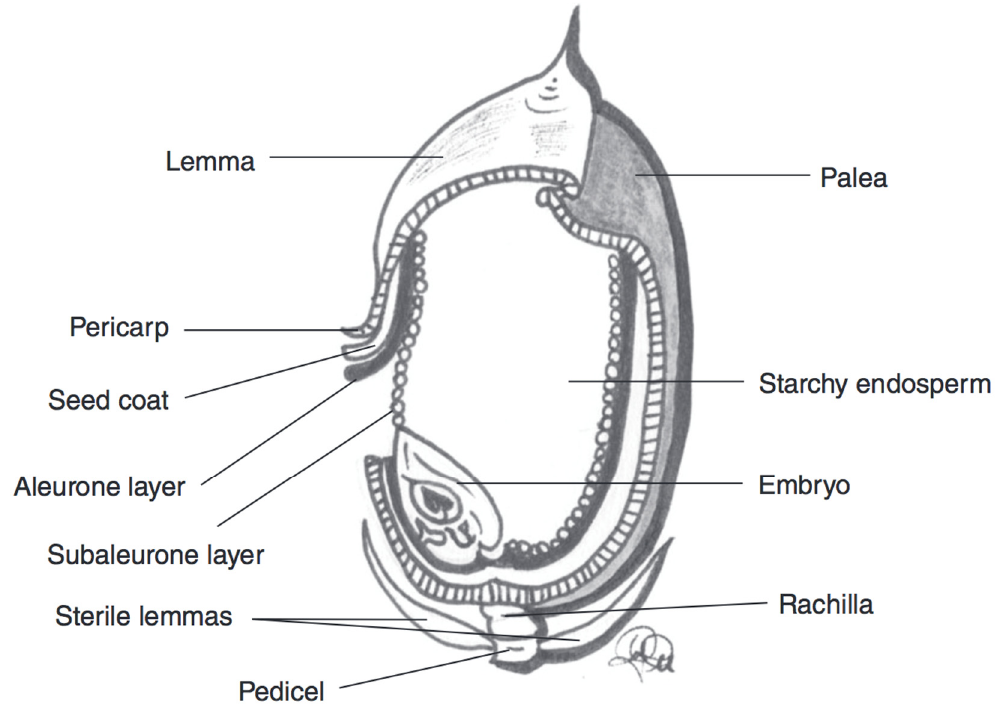
Figure 5. Schematic representation of a rice kernel cross-section, with component parts. Adapted from reference [27]. Table 4. Selection of studies focusing on total anthocyanin content (TAC) in various rice cultivars. The anthocyanin quantification method and assay used for antioxidant potential are also